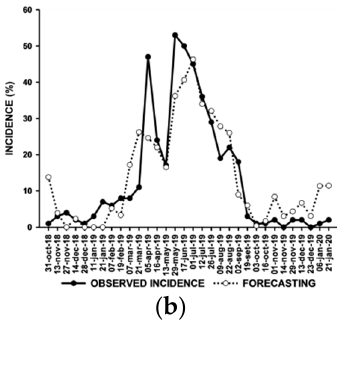
Table 6. Qualitative index used to select the best models and describe the accuracy of the models for the Carmo do Rio Claro and Nova Resende municipalities, Minas Gerais state, Brazil.